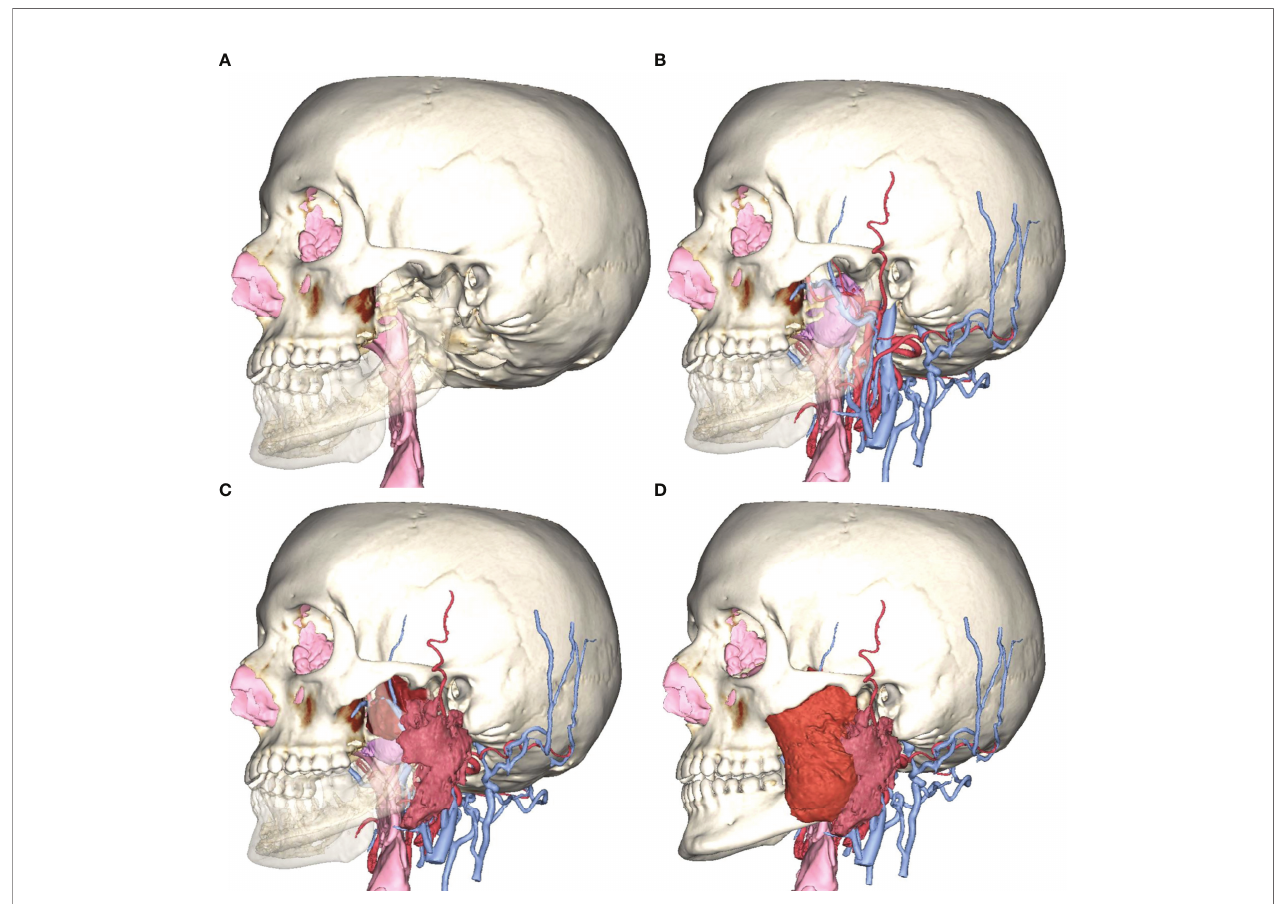
FIGURE 1 | Example of multilayer anatomical reconstruction. (A) Skeletal and mucosal framework; (B) reconstruction of tumor (purple), arteries, and veins; (C) reconstruction of the parotid gland; and (D) reconstruction of masticatory